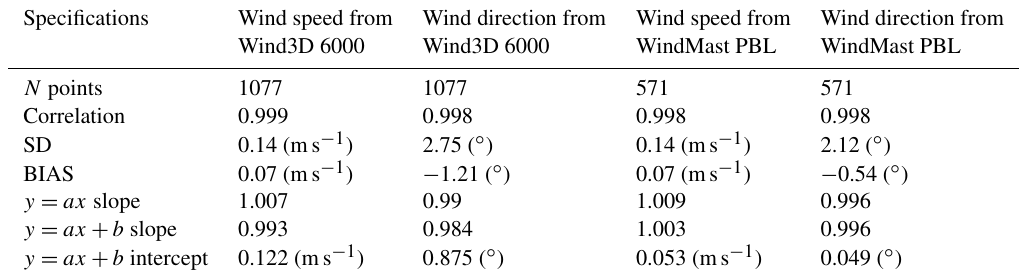
Table 4. Statistical results of the validation tests between Wind3D 6000, WindMast PBL and cup anemometers, and wind